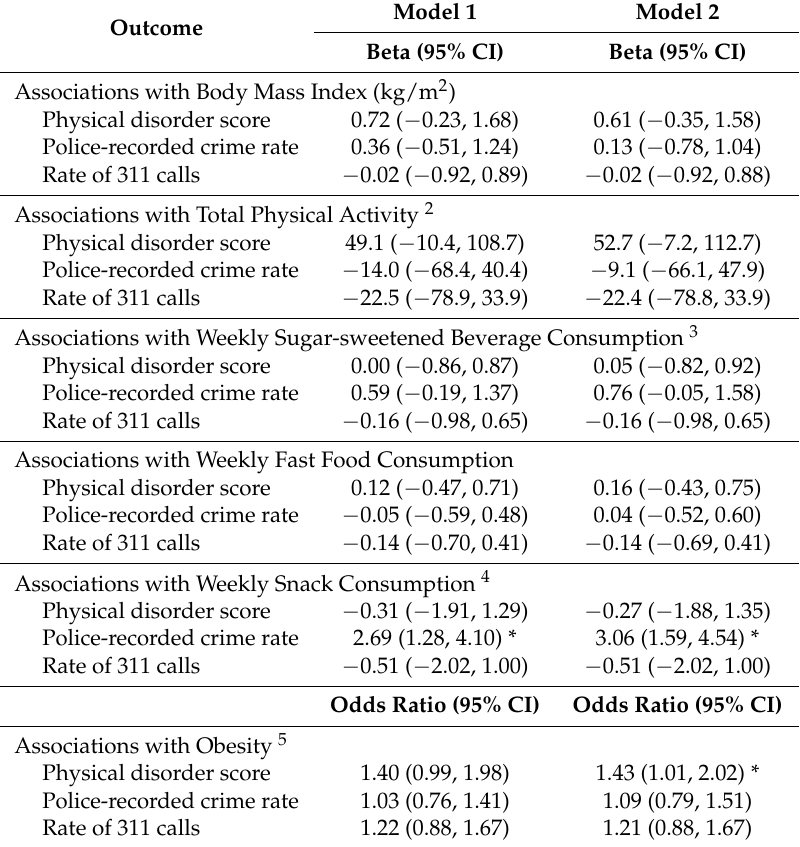
Table 3. Associations of neighborhood physical and social disorder with obesity-related outcomes 1